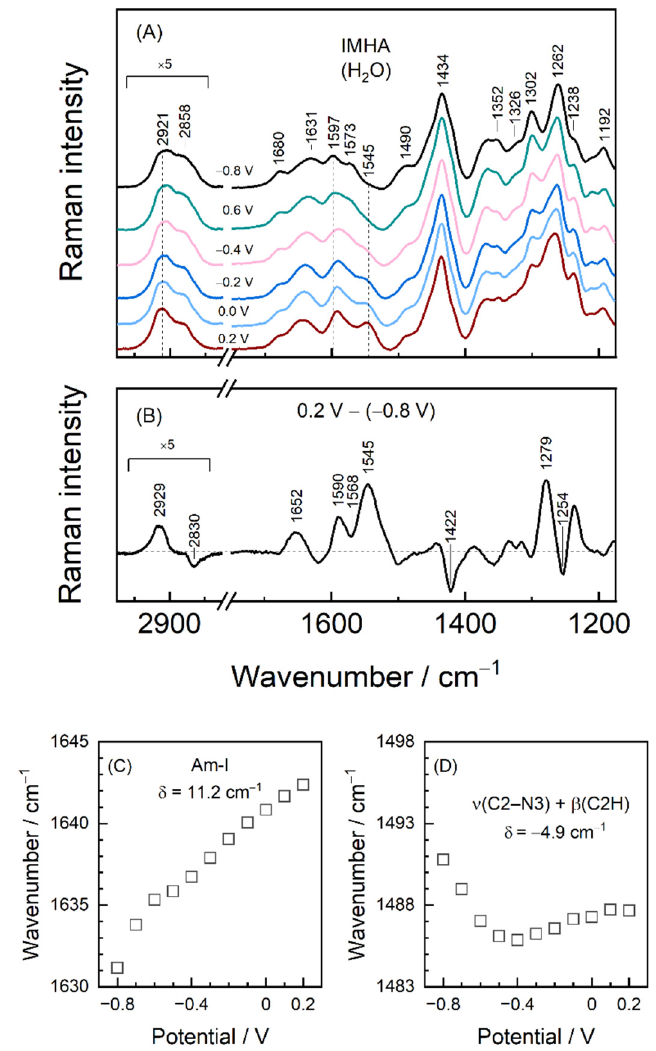
Figure 8. ( A ) EC-SHINERS spectra in 1120–1750 cm − 1 and 2750–3050 cm − 1 regions at indicated po- tentials. Spectra correspond to the ones in Figure 6. ( B ) EC-SHINERS difference spectrum constructed by subtracting 0.2 V spectrum from the one registered at − 0.8 V. ( C ) Potential dependence of the Amide-I and ( D ) ν (C2–N3) + β (C2H) mode wavenumbers.